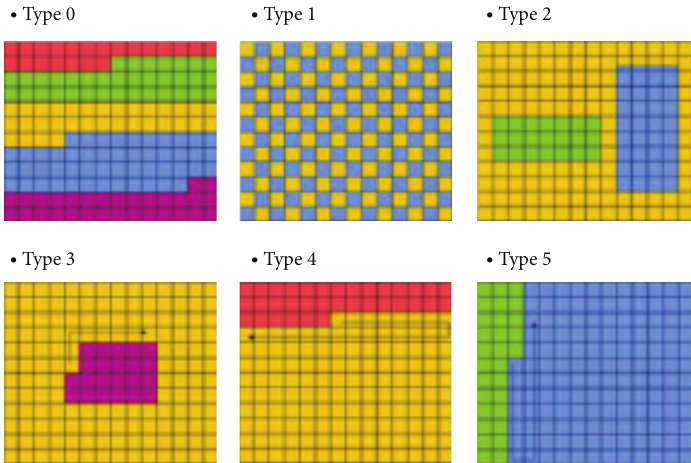
Figure 5: Six fixed types of the FMO (interleaved, dispersed, foreground, box out, raster scan, and wipe out), while each color represents a slice group [24].